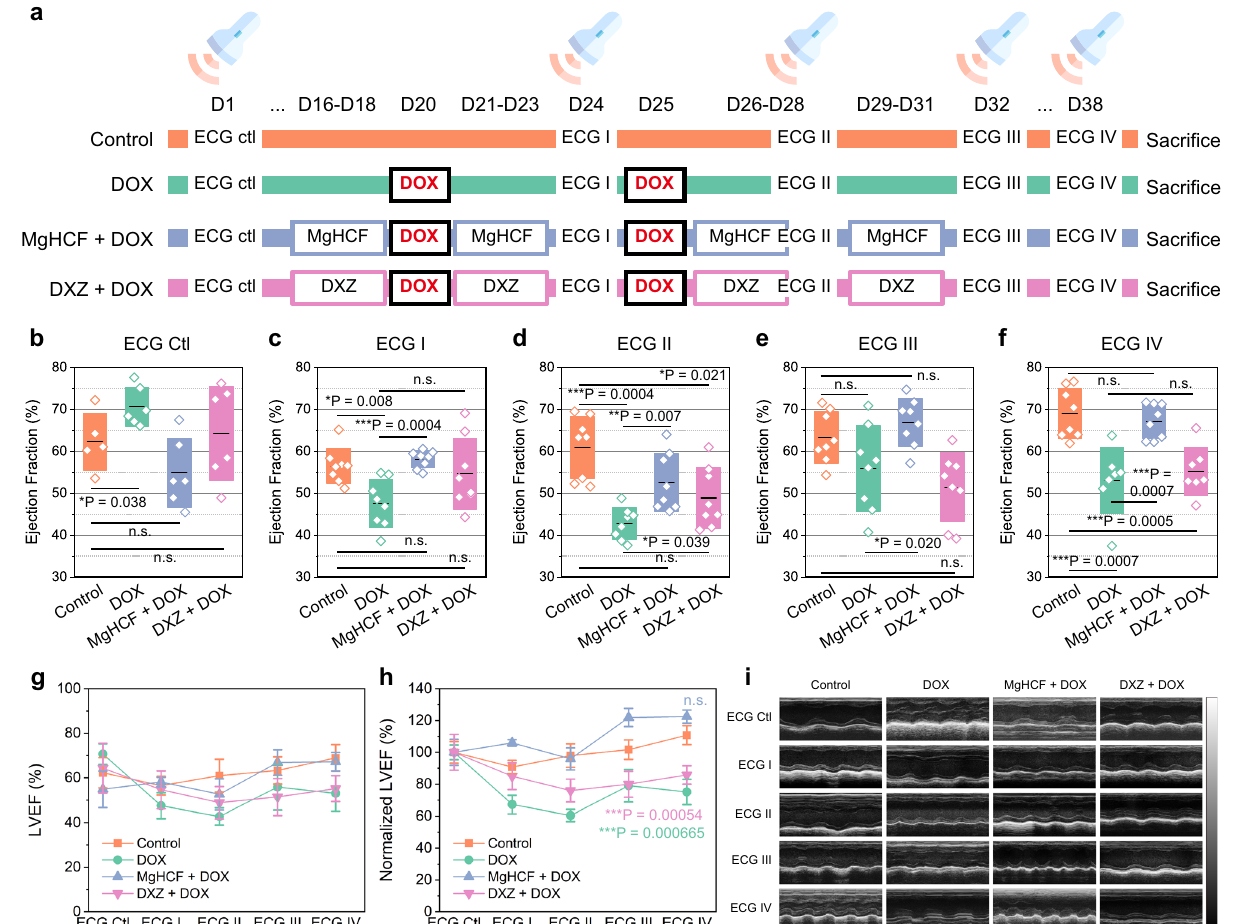
Fig.7|Invivoechocardiographyevaluation.a Invivodosingscheduleforinvivo echocardiography evaluation. b – f Left ventricular ejection fractions of mice in differentgroupsbyechocardiographyinspections: b ECGCtl( n =6); c ECGI( n